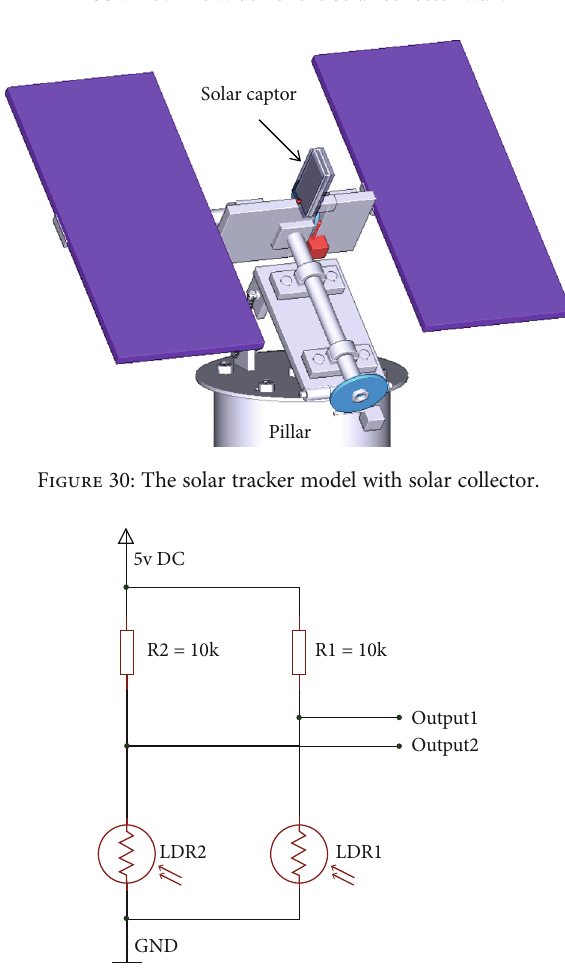
Figure 29: The width of the solar collector wall.